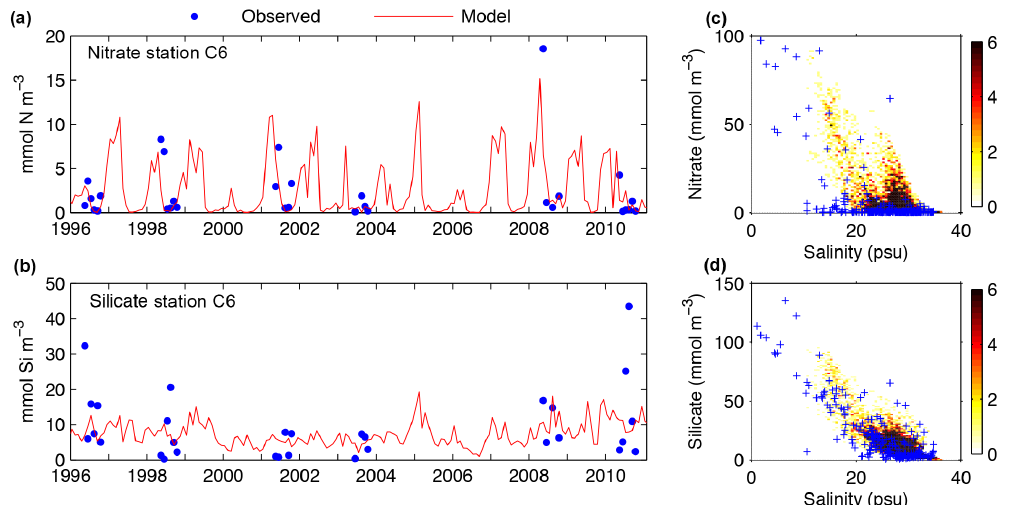
Figure 7. (a, b) Model–data comparison of nitrate and silicate time series at station C6 (28.86 ◦ N, 90.46 ◦ W); (c, d) relationship between surface salinity and both nitrate and silicate concentration over the Louisiana–Texas shelf. Modeled values are shown as two-dimensional histogram (color scale), and observations as blue marks.